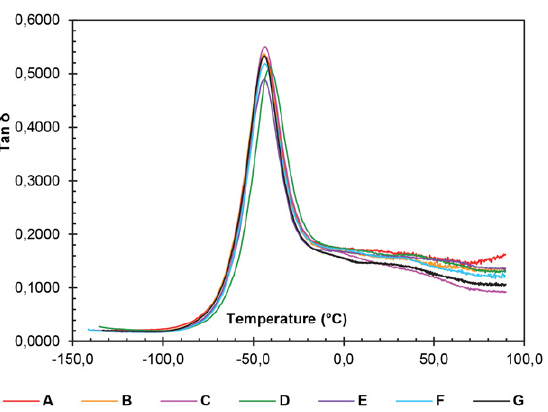
Figure 5. SS-CSC[4]A molecular structure.